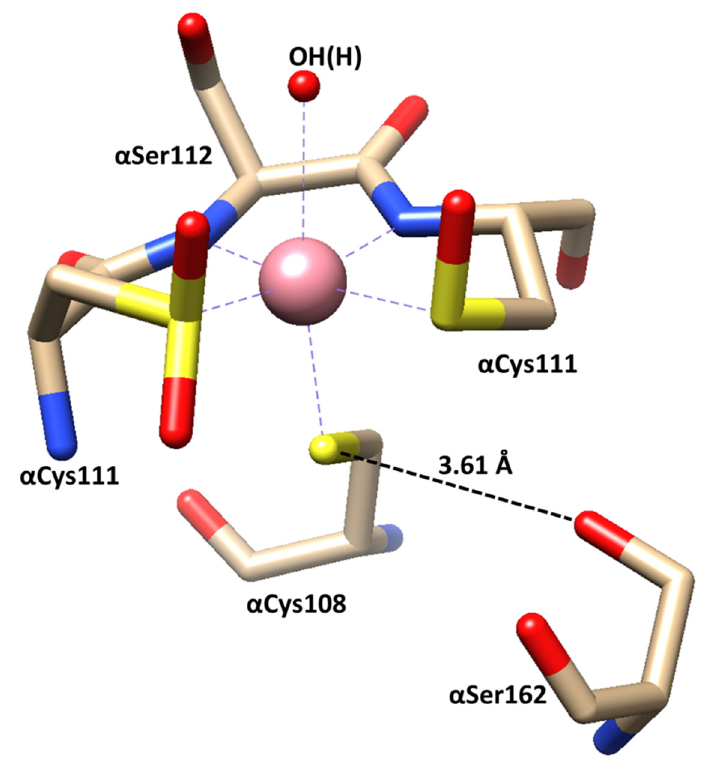
Figure 1. Active site of Pt NHase (PDB:1IRE). Dashed line, distance between sulfur atom of axial Cys108 ligand and oxygen atom of OH group of α Ser162.